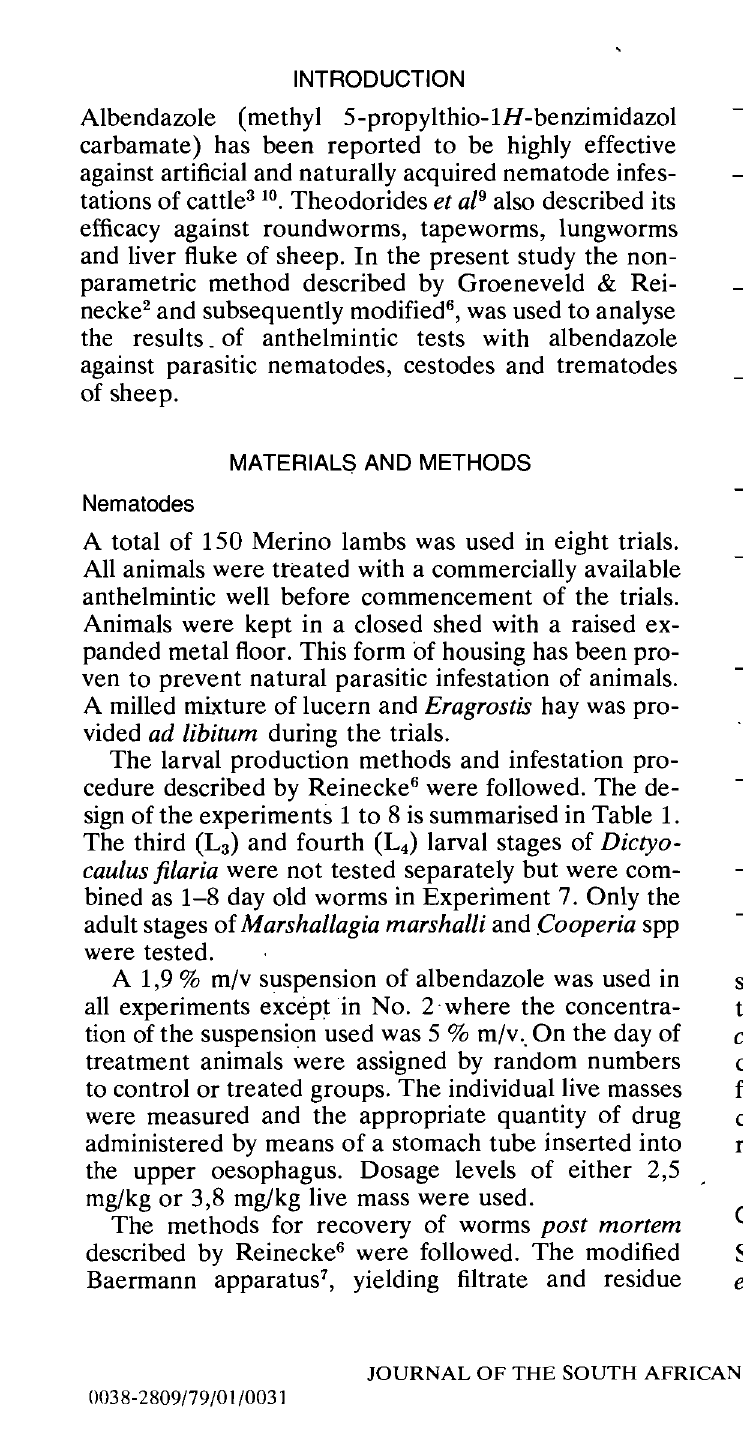
Table 1: DESIGN OF